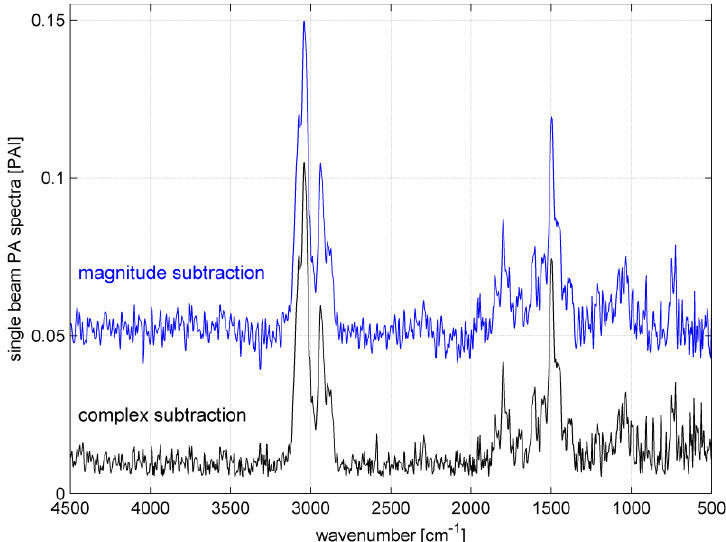
Figure 3. Comparison of the background subtraction performed as complex and magnitude as an example of toluene at 100 ppm. To make this figure well arranged, the result spectrum of the complex subtraction is plotted with an offset of +0.005 PAI and the result spectrum for the magnitude subtraction with +0.05